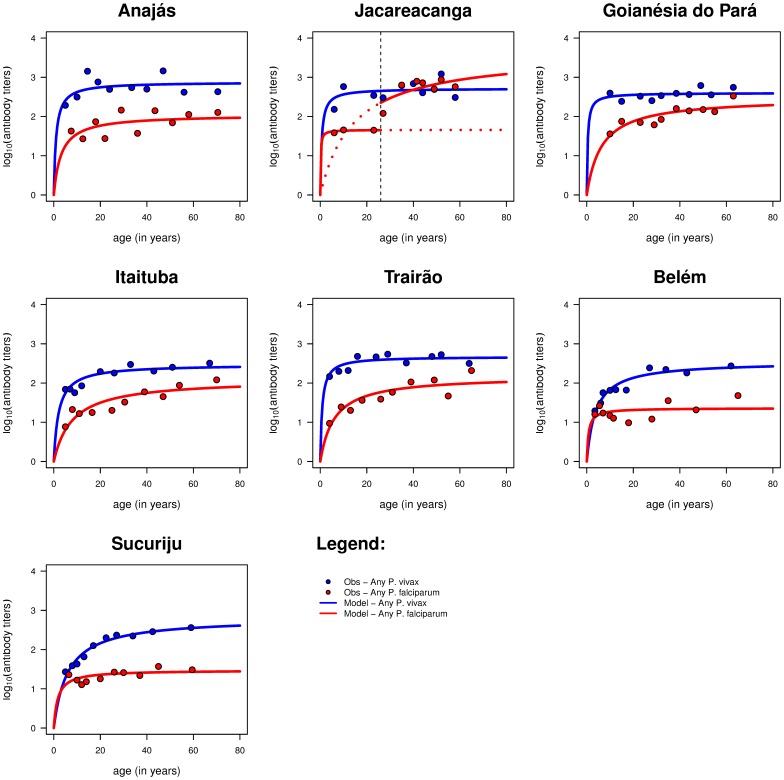
Statistical analysis of antibody titers data.Age-adjusted log10-transformed antibody titer profiles for any P. vivax (blue solid lines) or P. falciparum antigens (red solid lines) using appropriate Michaelis-Menten models. Blue- and red-filled circles represent the observed mean antibody titer after pooling the data according to the 10%-centiles of the underlying age distribution. The antibody levels refer to the maximum among these reacting to AMA1 and the MSP1 antigens.